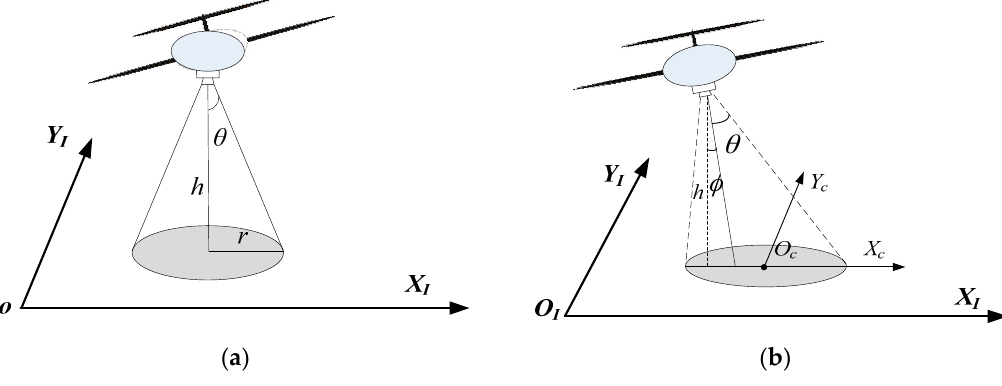
Figure 2. Illustration of the sensor convergence areas with different types of sensors. ( a ) illustrates the visibility regions of gimbaled sensors when the aircraft is turning; ( b ) depicts the visibility regions of body-fixed sensors when the aircraft is turning.